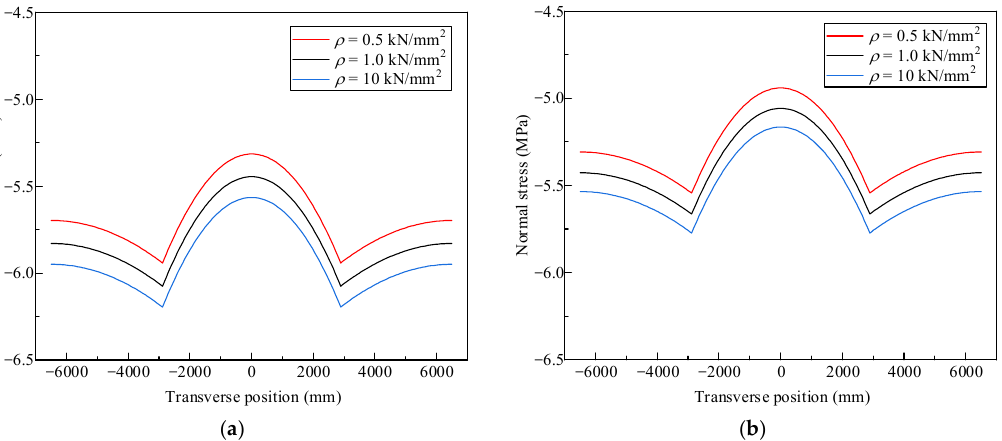
Figure 11. Stress on the concrete slab of composite beams (influence of shear connection stiffness). ( a ) 28 days; ( b ) 3 years.